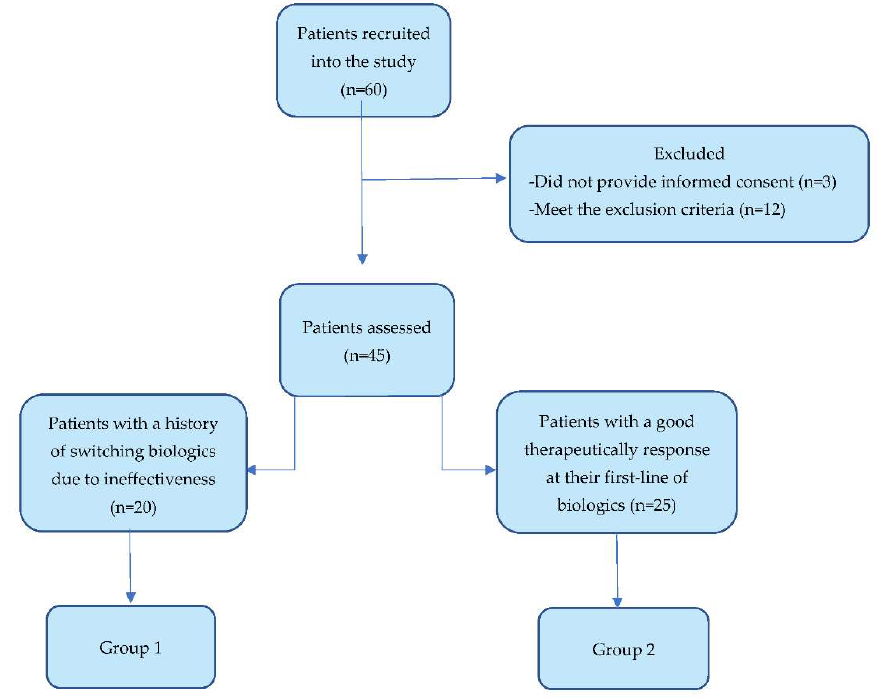
Figure 1. Flowchart of patients included in the study and distribution criteria for the two groups . The lack of efficacy was described as patients with ≤50% reduction in disease severity (calculated by PASI score) and without an appropriate improvement in physical, social, or psychological functioning described with ≤5-point improvement in DLQI score, or patients who lose their initial satisfactory response afterward [27].